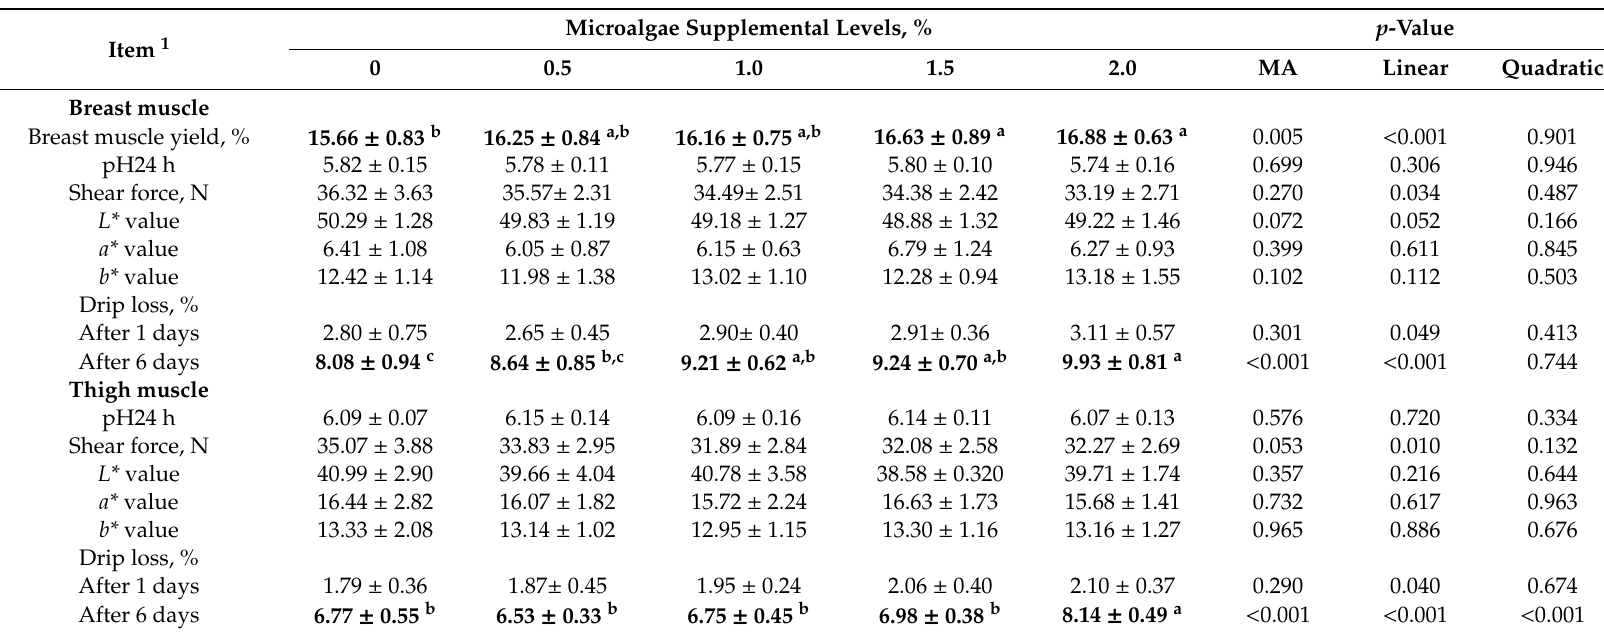
Values are means ± standard deviations ( n = 12). Bold-faced means in the same row with di ff erent letters di ff er significantly ( p < 0.05). L * value, lightness; a * , redness; b * value,